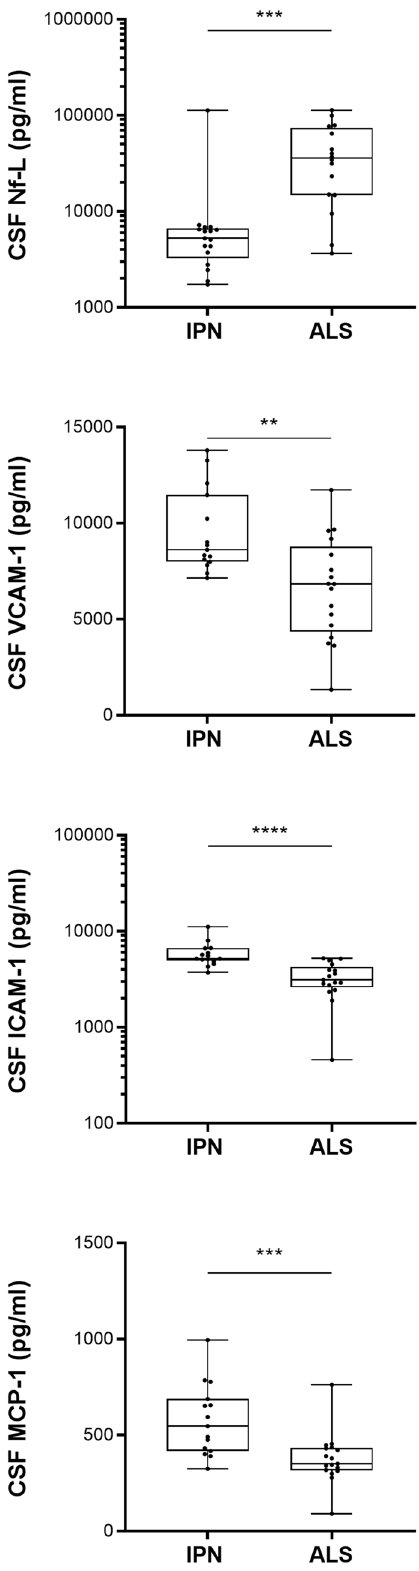
Figure 3. CSF markers in ALS and IPN. Difference in CSF markers between ALS and IPN patients. Mann Whitney tests significance levels are indicated on graphs (** p < 0.01; *** p < 0.001; **** p <